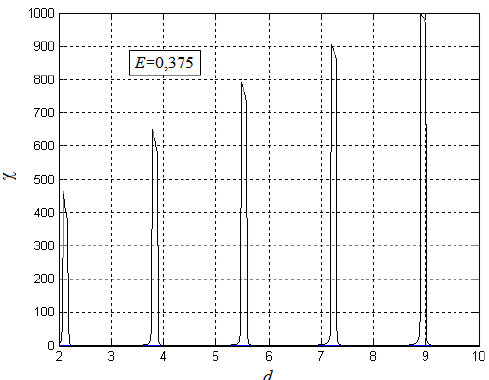
Figures 8, 9 show that at low temperatures there are areas that correspond to super-permeability of the compos- ite membrane with respect to helion. Moreover, the system as a whole is characterized by hyper-selectivity. In addi- tion, with a decrease in temperature, an expansion of the super-permeability bands is observed.